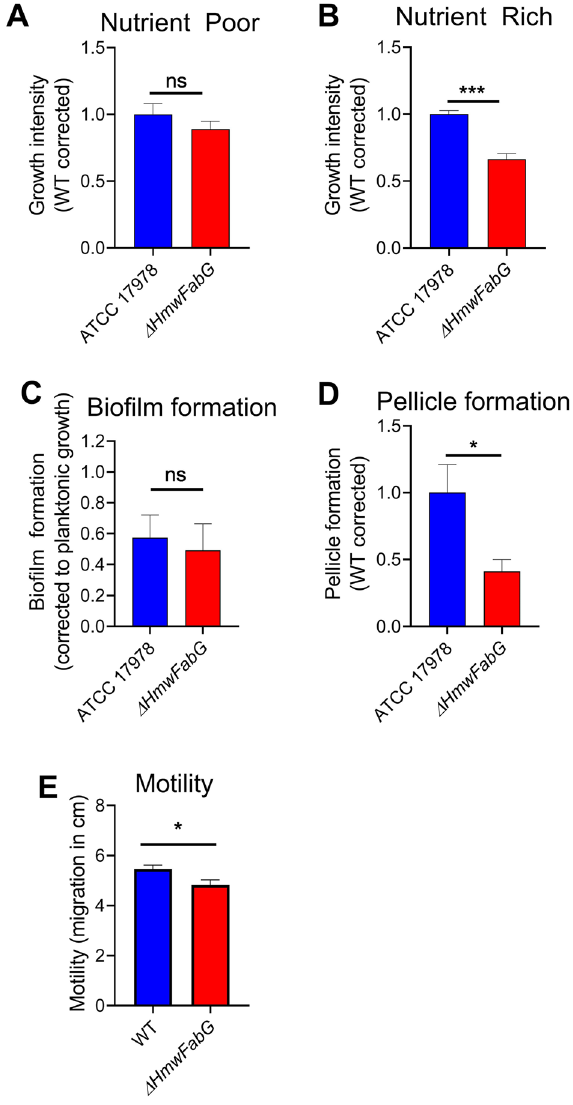
Figure 5. HMwFabG is important for pellicle formation, motility and growth under nutrient rich conditions. Growth of ATCC 17978 and ΔAbHMwfabG in nutrient poor conditions ( A ), and nutrient rich conditions ( B ). Biofilm (OD 590 /OD 600 ) ( C ), pellicle ( D ) and motility ( E ) of ATCC 17978 and ΔAbHMwfabG. For all panels, results are the mean ± standard error of the mean (SEM) from at least biological quadruplicates. Statistical analyses were performed using an unpaired, two-tailed Student’s t -test; * p < 0.05, *** p < 0.001, ns = not